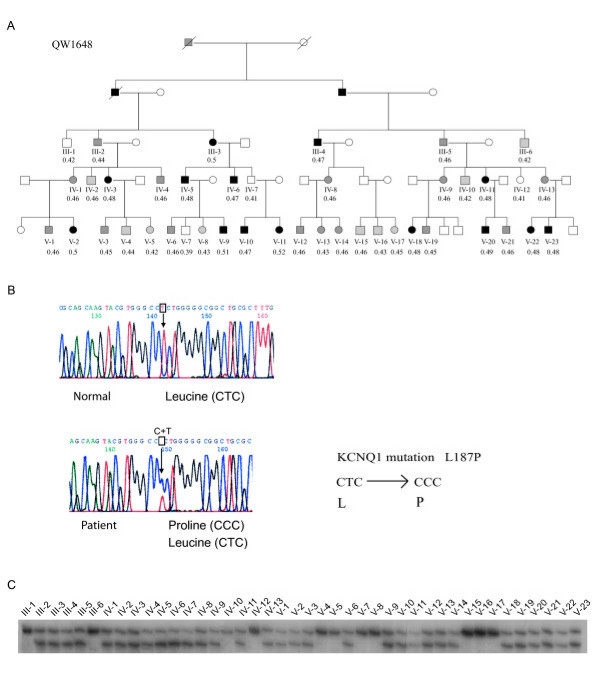
Identification of a novel mutation, L187P, in KCNQ1 in LQTS family QW1648. (A). A partial pedigree structure for the large Utah family is shown. The family had over 300 members. For ease of illustration only a portion of the pedigree is shown. Affected males and females are indicated by filled squares and circles, respectively. Normal individuals are shown as empty symbols. Individuals with uncertain LQTS diagnosis are shown with gray symbols. Deceased individuals are shown using slashes. The identification numbers for family members and QTc are shown below symbols. (B). DNA sequence analysis revealed a heterozygous T→C transition at nucleotide 560 of KCNQ1, which results in a substitution of amino acid residue leucine by a proline residue (L187P). The sequence for a normal family member is shown on the top and the sequence for an affected family member is shown below. (C). SSCP analysis showed co-segregation of the mutation L187P with the LQTS phenotype in the family. All phenotypically affected members had two bands, and the non-affected individuals had only one band.